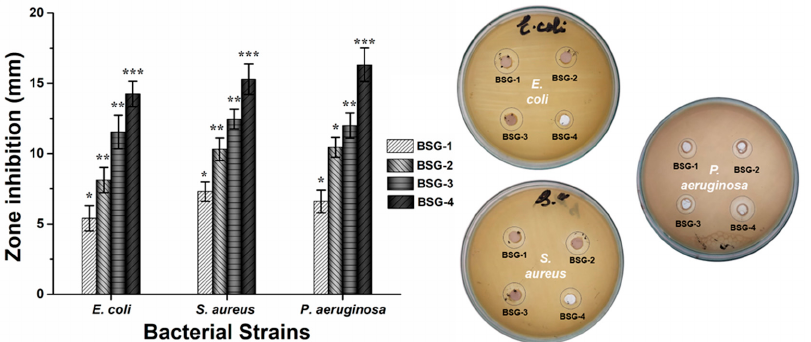
Figure 7. The antibacterial activities of composite hydrogels against different severe skin infections causing Gram-positive and Gram-negative pathogens. * p < 0.05, ** p < 0.01 and *** p < 0.001 and n = 3.